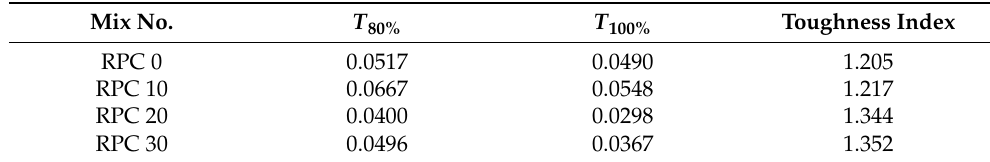
Table 2. Toughness index for rubber-concrete.